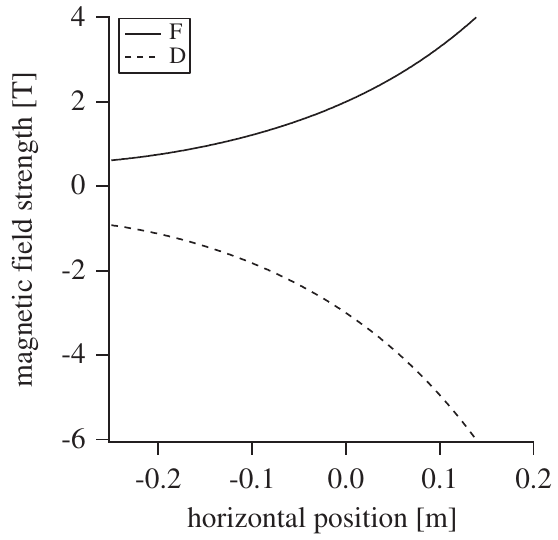
FIG. 2. Field profile of the magnet made from multipoles up to decapole.